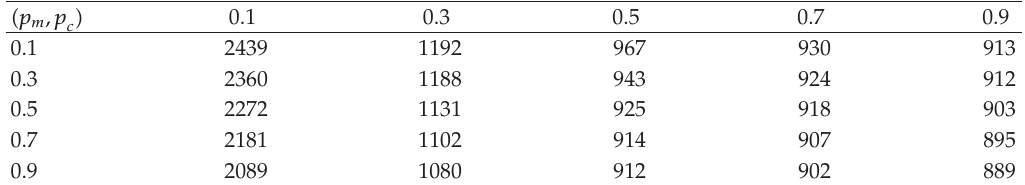
Table 12: The e ff ect of the crossover probability and the mutation probability on the convergence speed of the CGA for Problem 1.